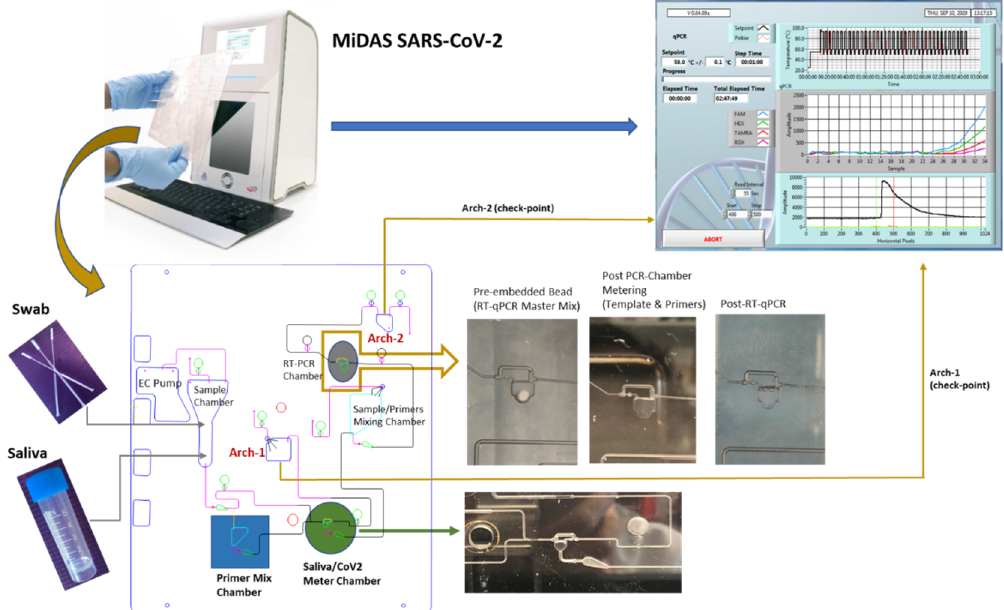
Figure 2. Illustration of the on-MiDAS SARS-CoV-2 detection workflow from saliva sample-in to test result-out. The top panel demonstrates from saliva-in to qPCR result-out. The lower panel details the check points at each functional step during every cartridge in process. The sample chamber can be loaded with saliva or swab specimen. The images show PCR chambers: pre-embedded with lyophilized RT-qPCR master mix bead, post PCR-chamber metering, and post on-cartridge RT-qPCR, and were all taken from a real cartridge. The green arrow points to the image taken from a cartridge with fully metered 20 µL saliva specimen.